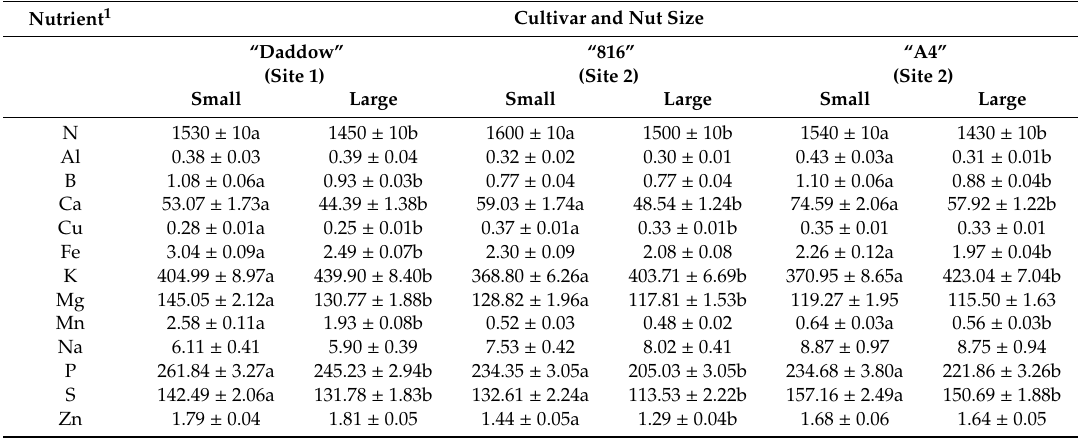
Table 4. Relationships between nut size and mineral nutrient concentrations (mg / 100g) in kernels from macadamia cultivars, “Daddow”, “816” and “A4”, each sampled at one of two commercial orchard